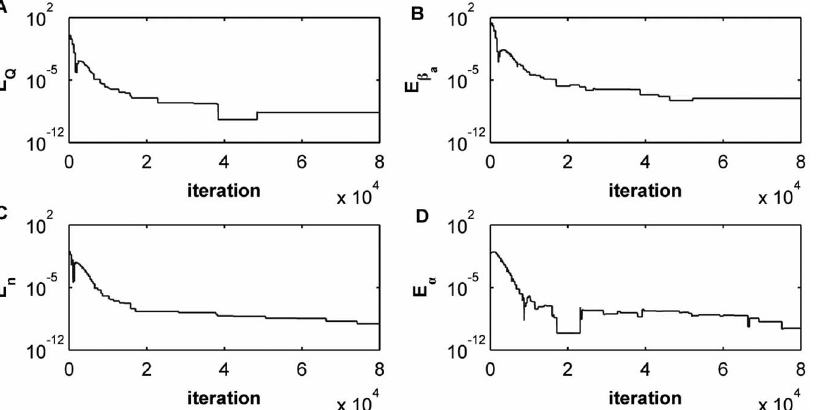
Figure 3. Normalized quadratic errors for each parameter as a function of the number of iterations for the ARS algorithm. (A) Q , (B) b a , (C ) n and (D) a .